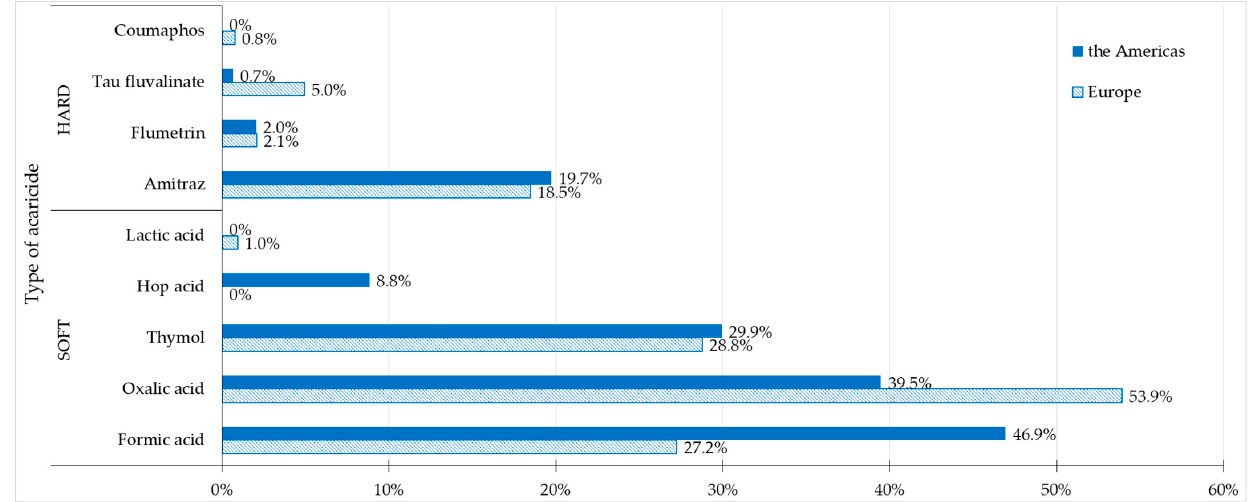
Figure 3. Active ingredients, grouped as “Hard” and “Soft” acaricides, used by American and European beekeepers.